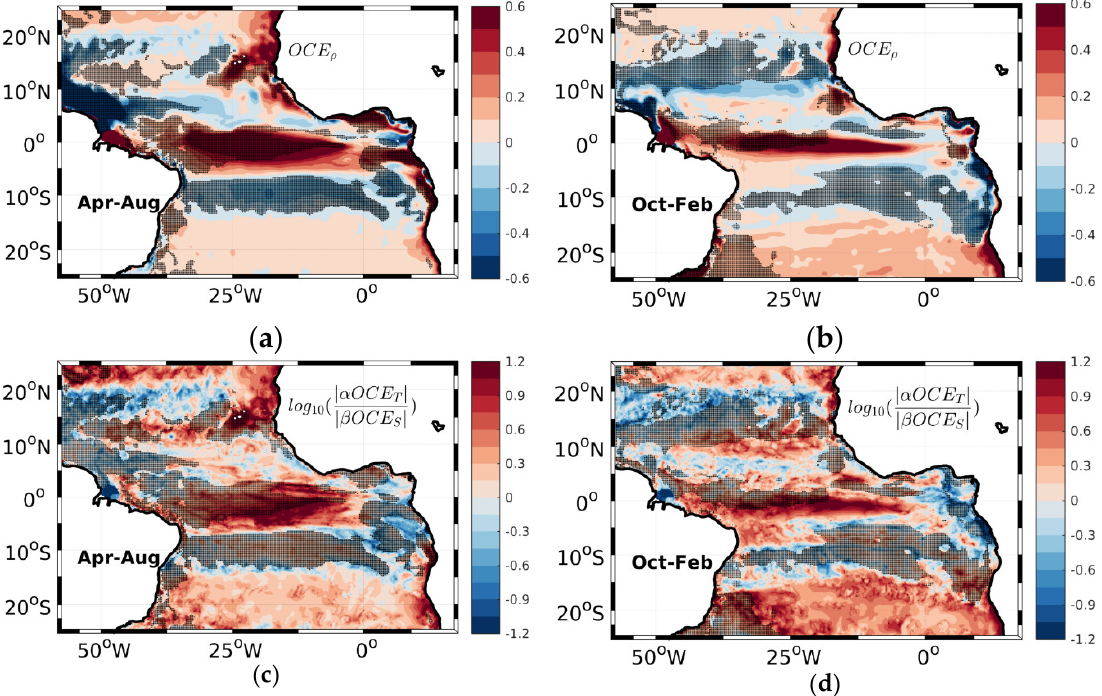
Figure 4. Similar to Figure 3 but for the contribution of total oceanic physical processes to mixed layer density variations.